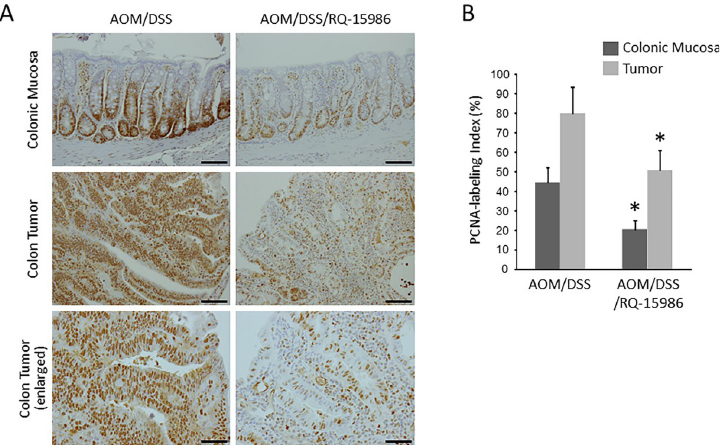
Fig 3. Effects of RQ15986 on cellular proliferation in the colonic mucosa and tumor. (A) Representative images of immunohistochemical staining in the colonic mucosa and tumor of AOM/DSS-treated KAD rats with anti-PCNA antibody. Scale bars, 100 μ m. (B) PCNA-labeling index in the colonic mucosa and tumor of AOM/DSS-treated KAD rats. Each column represents the mean ± SD. Asterisk indicates statistically significant difference compared to the index in AOM/DSS group; P < 0.05.